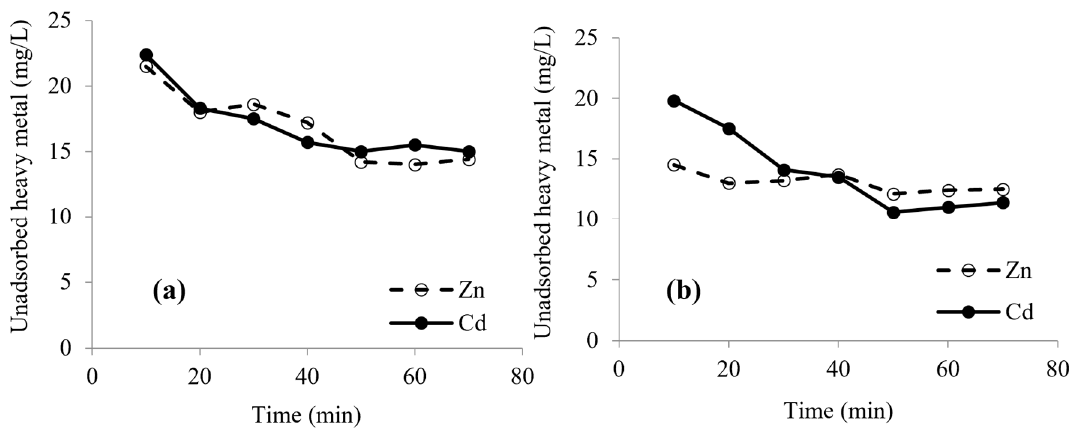
Figure 4. Effect of time on biosorption of Zn 2+ and Cd 2+ by living ( a ) and lyophilized ( b ) cells of Priestia megaterium PRJNA526404.